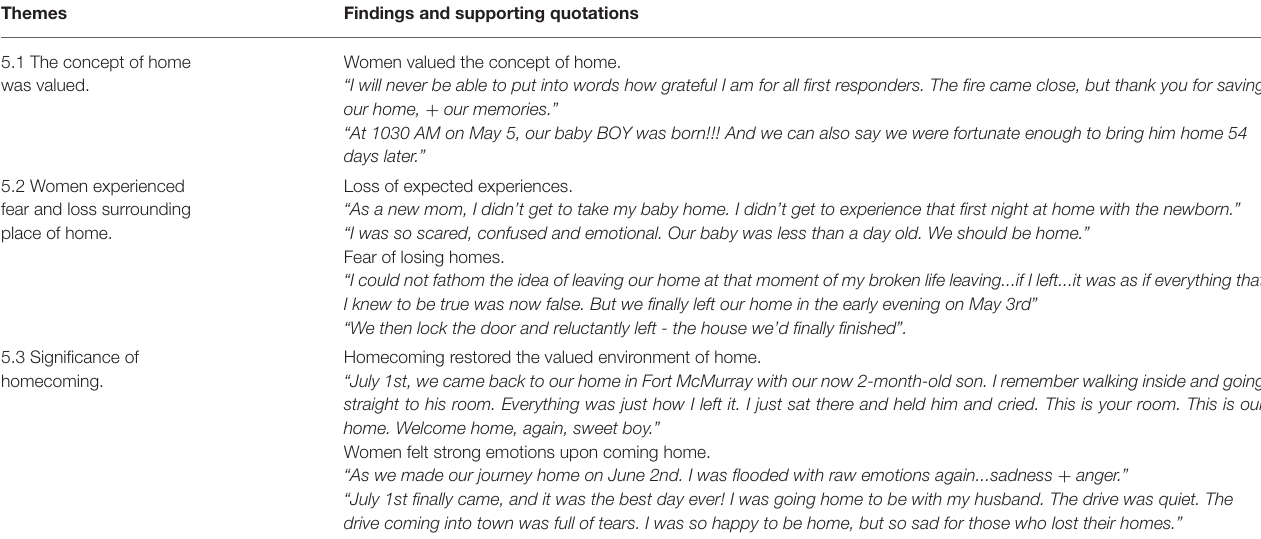
TABLE 5 | Theme 5: Place of home was important in women’s experiences.